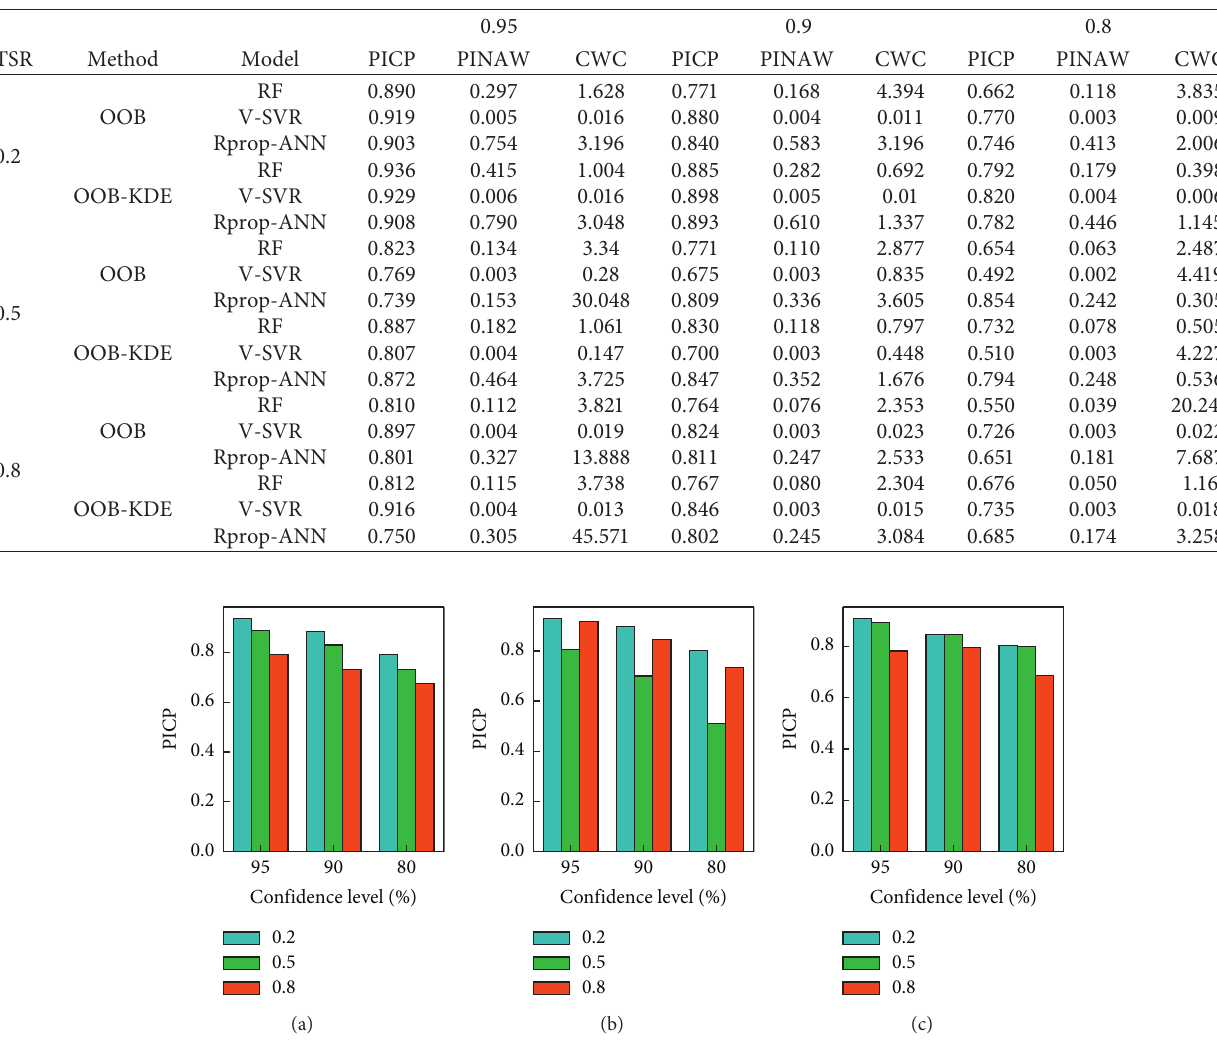
Table 4: Comparison of PIs obtained using OOB and OOB-KDE methods.